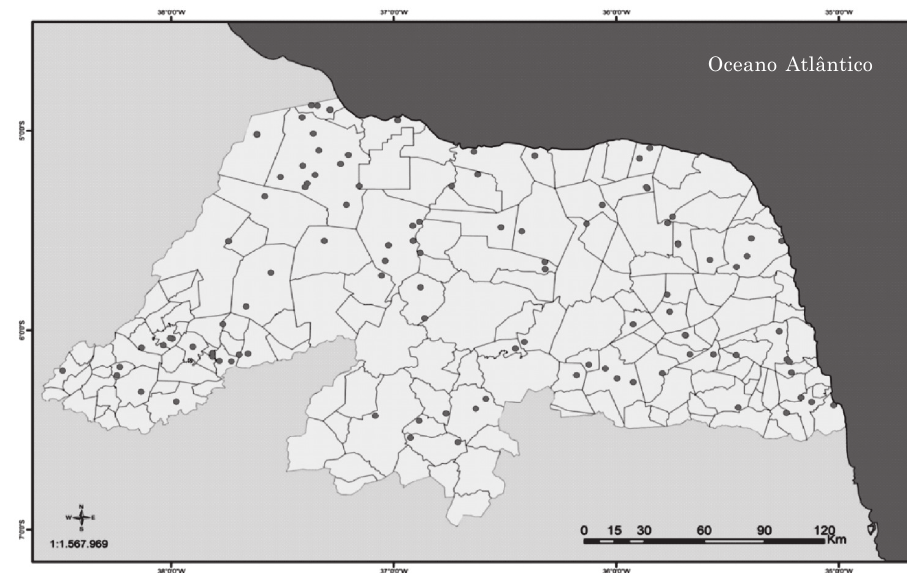
Figura 1. Distribuição dos locais de coleta de solo no Estado do Rio Grande do